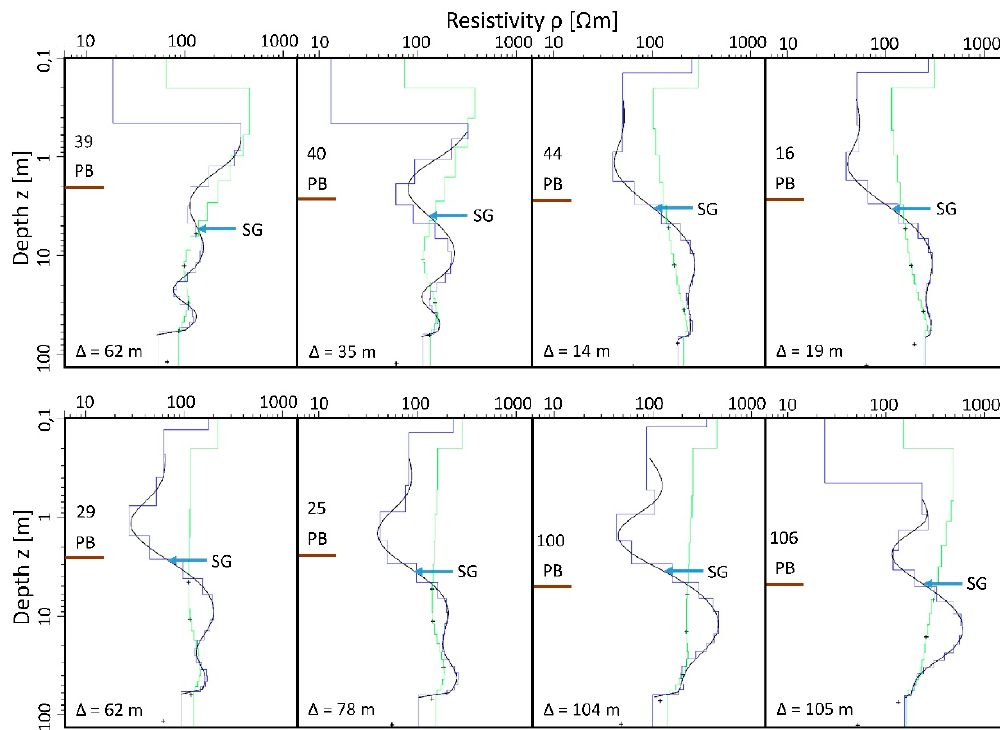
Figure 14. Comparison of peat thicknesses derived from steepest gradient (SG, blue arrows) analysis of smooth 20-layer HEM inversion models (green / blue / black: starting / final / interpolated models) and drilled peat base (PB, brown lines) along flight line L94.1. The distances of the boreholes (numbers) from the flight line ( ∆ ) are indicated.